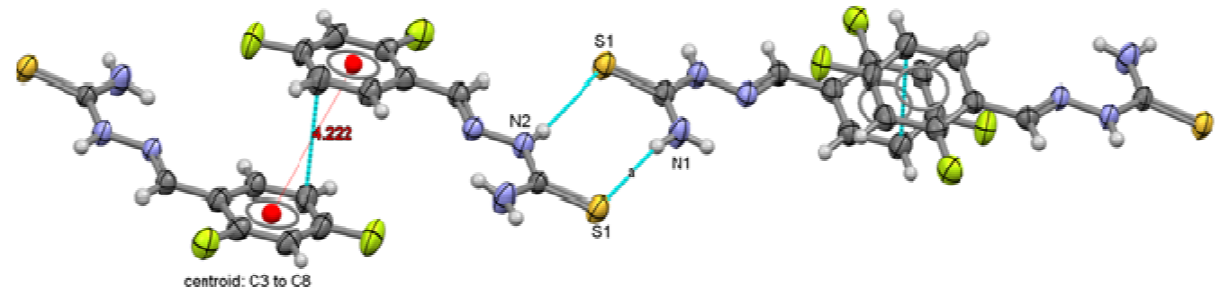
H F -CH=N-NH-C(S)NH 6 3 2